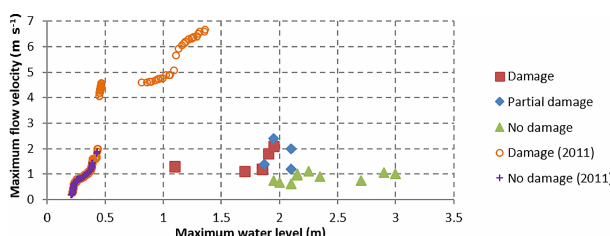
age value, an analysis of variance (ANOVA) was performed.